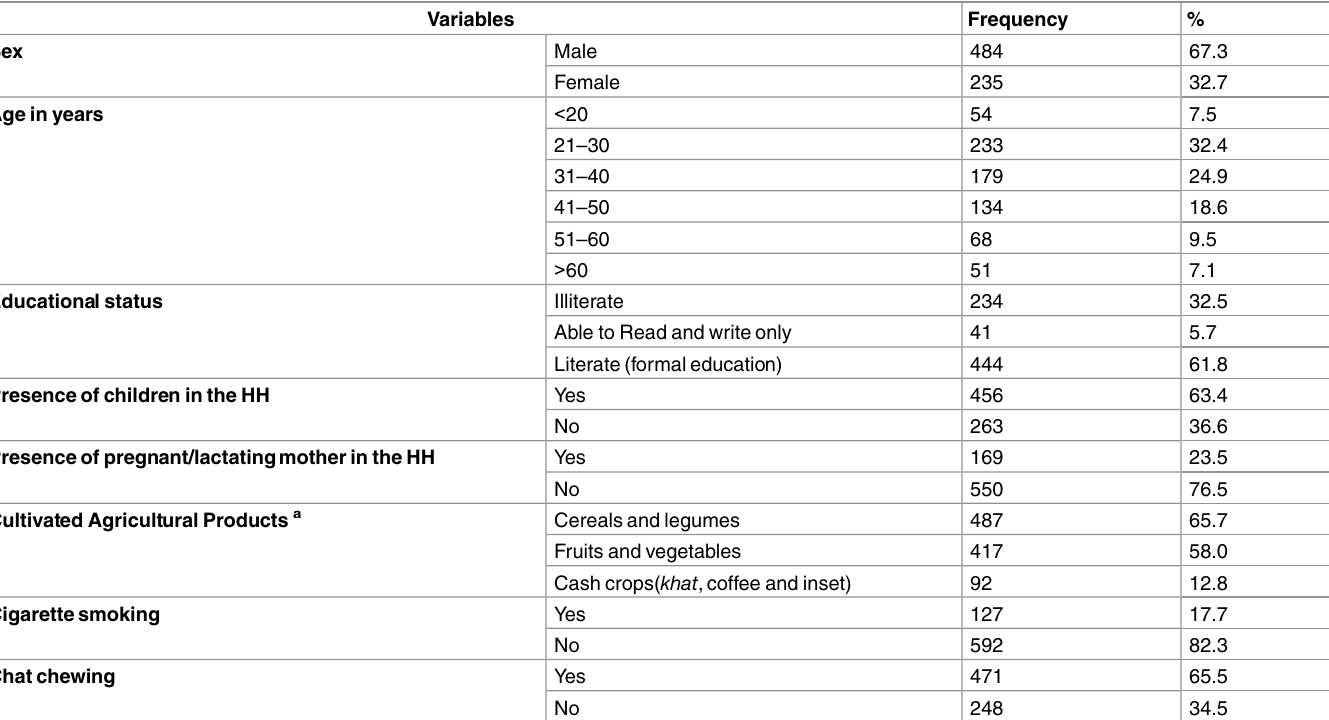
Table 1. Characteristics of